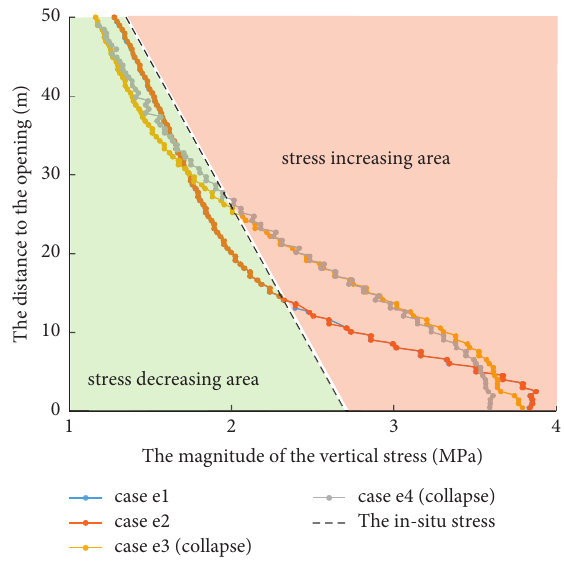
Figure 13: The relationship between the vertical stress and the distance to the opening. The rock masses in cases e1 and e2 are not collapsed, whereas the collapse has occurred in cases e3 and